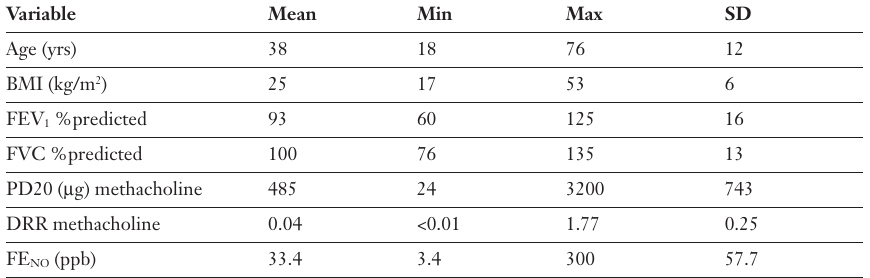
Sample characteris- tics and descriptive statistics of the asth- matic patients (n = 57, male/female = 32/25).